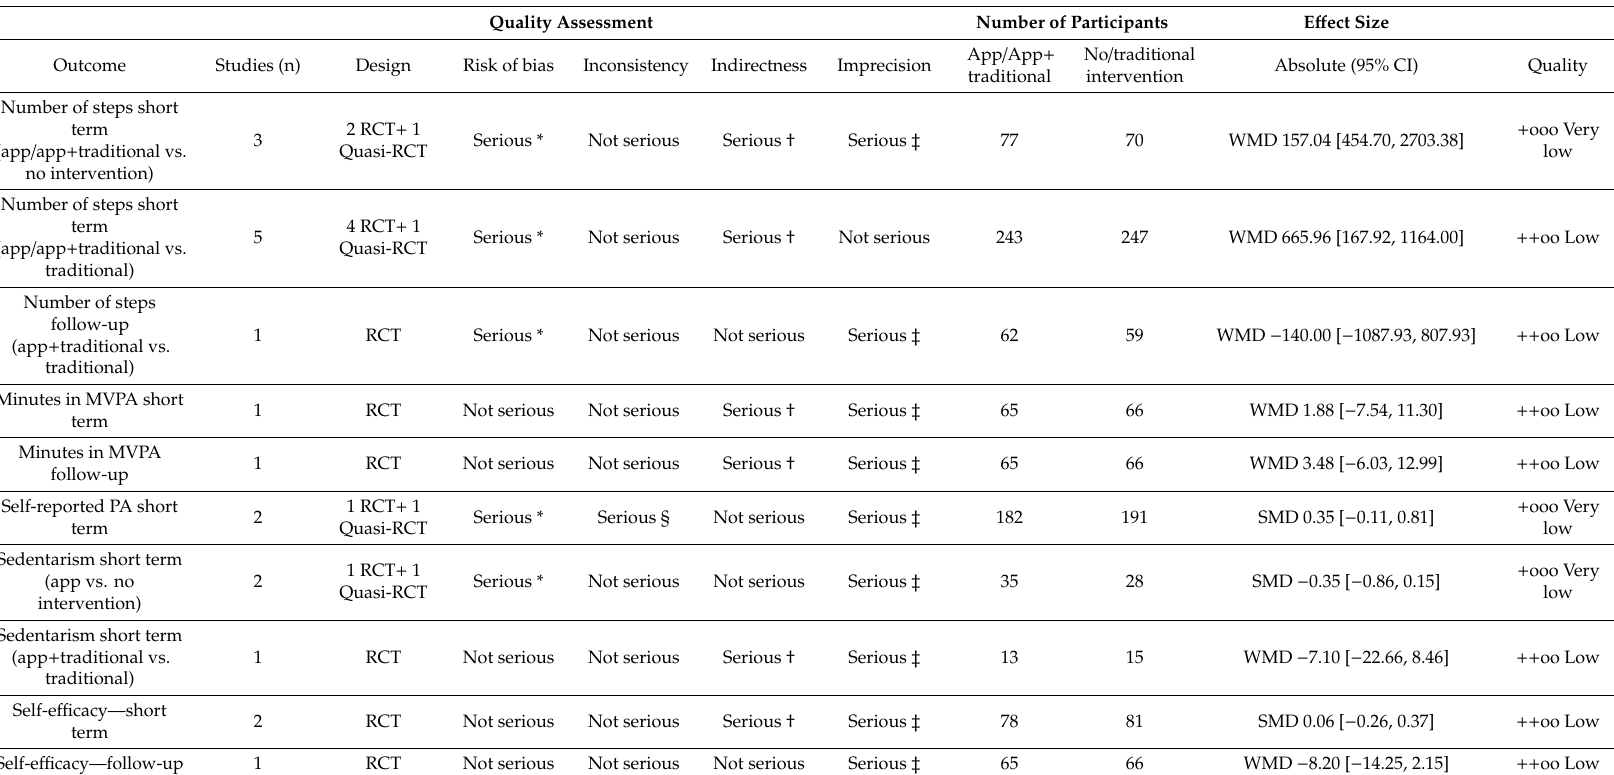
Table 2. Grading of Recommendations, Assessment, Development, and Evaluation (GRADE) evidence profile and summary of